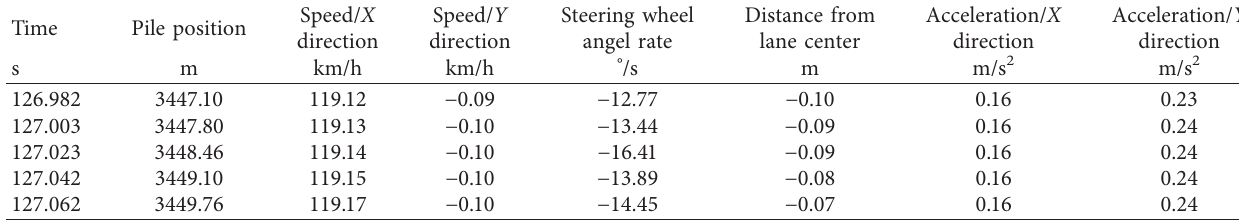
Table 2: Output parameters of driving simulation